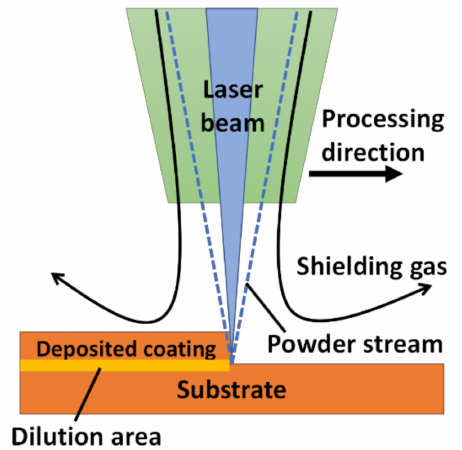
Figure 2. Schematic of laser melting deposition (LMD)